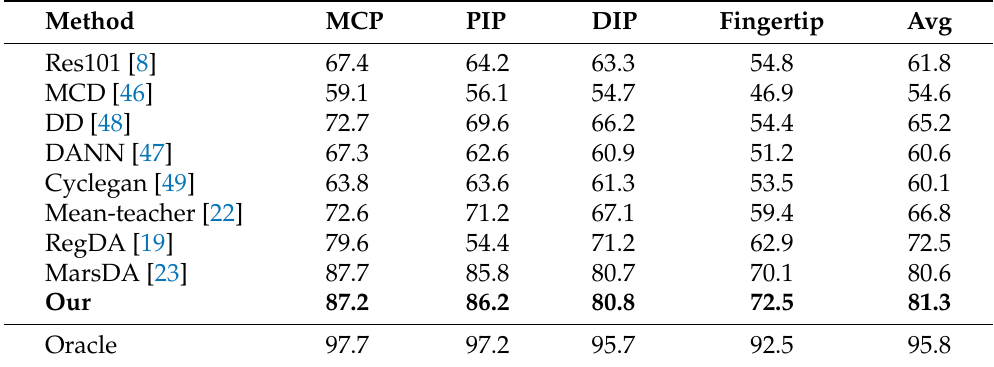
Table 1. Results on the task RHD → H3D. The last row (oracle) denotes the results of training with target domain